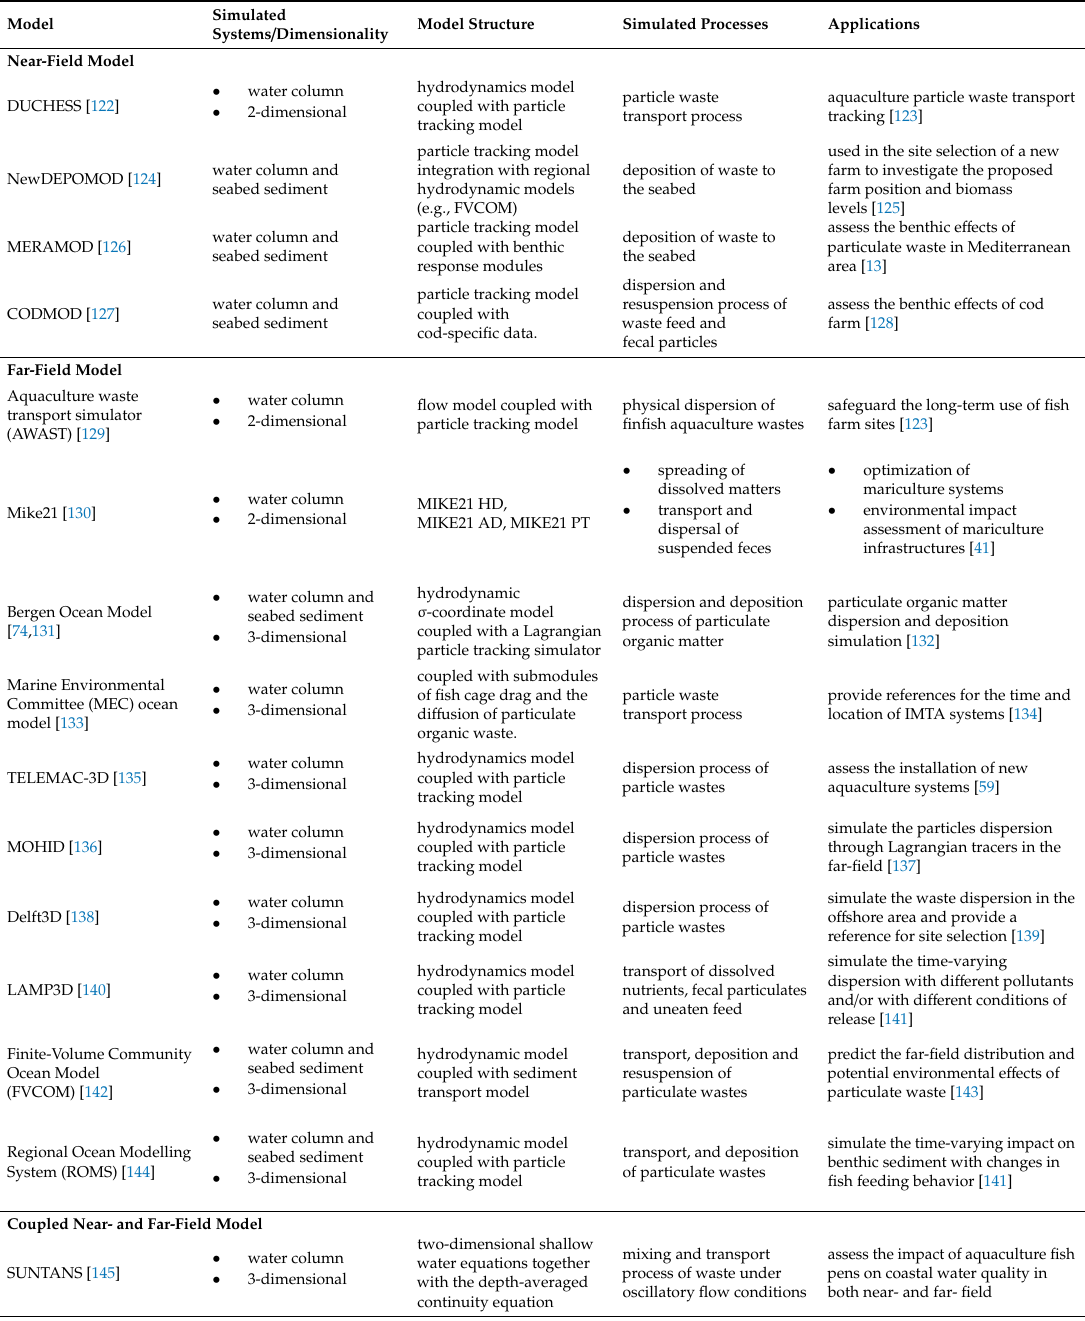
Table 6. List of models used in the management of mariculture e ffl